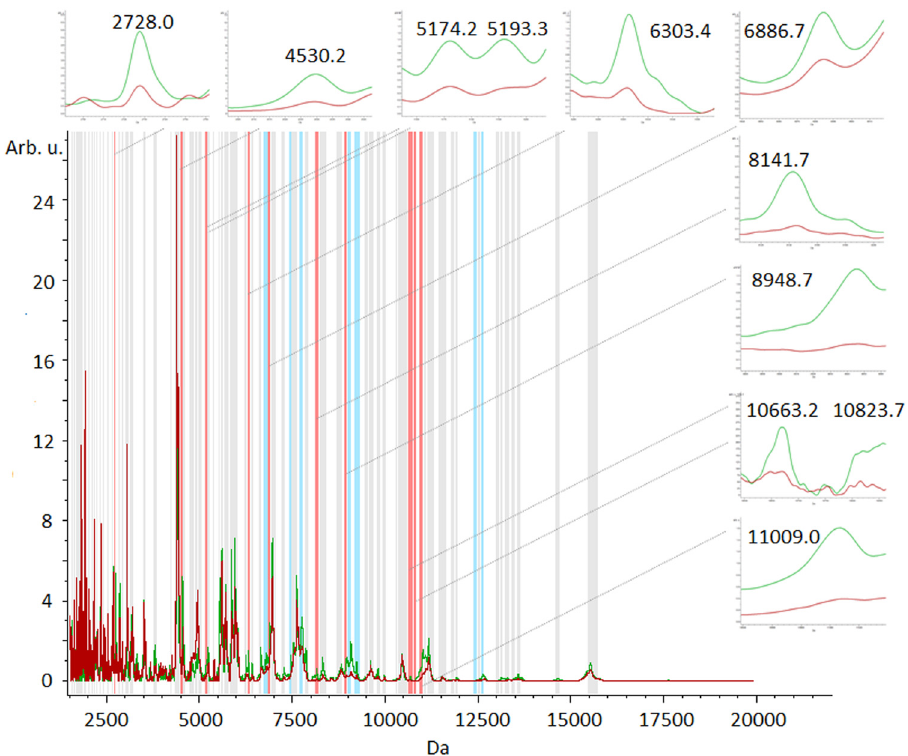
Figure 4: Location of discriminating peak masses ( m / z 2728.0, 4530.2, 5174.2, 5193.3, 6303.4, 6886.7, 8141.7, 8948.7, 10663.2, 10823.7, and 11009.0 ) determined by the SNN. Red and green denote the control and TMD groups, respectively.